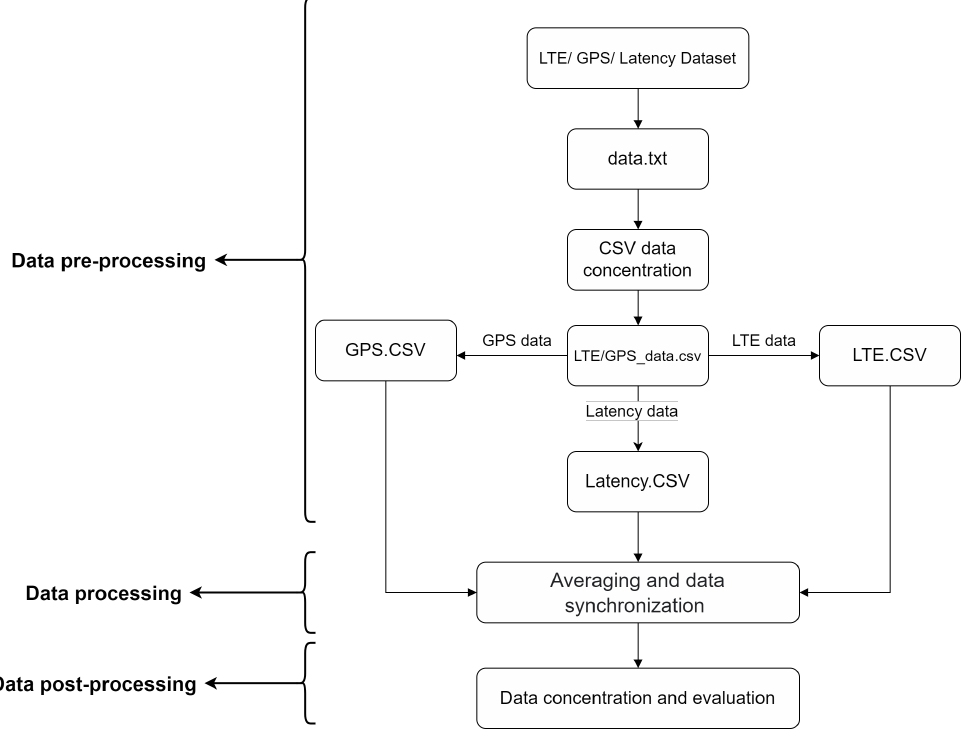
Figure 10. Data processing block